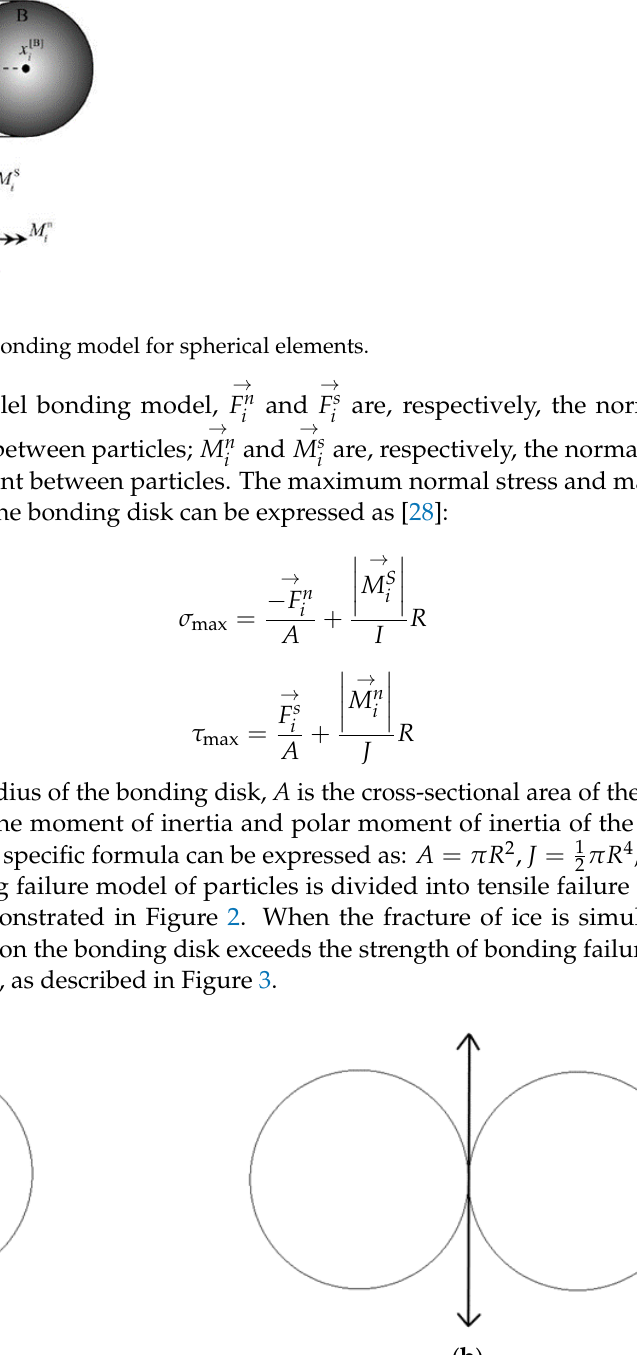
0.35 Table 3. Main parameters of water and air in finite element calculation.